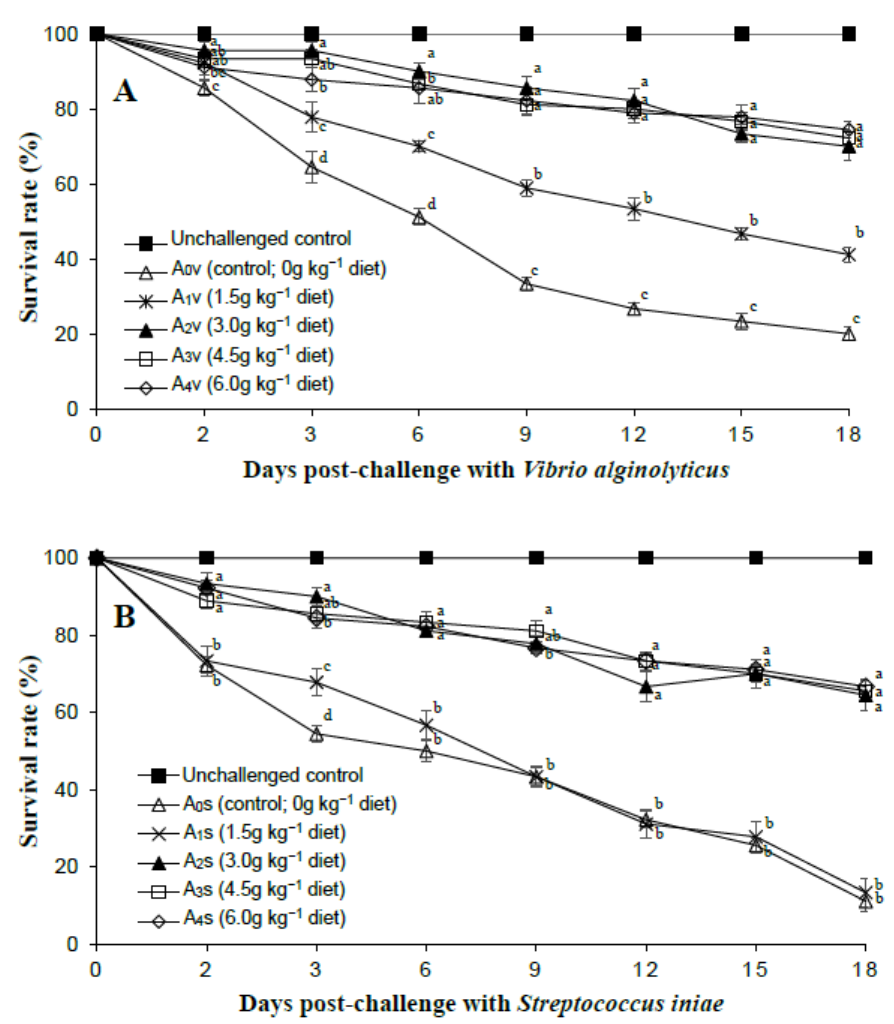
Figure 1. The curves of survival rate of Vibrio alginolyticus - ( A ) and Streptococcus iniae ( B )-challenged orange-spotted grouper fed with diets containing different levels of Antrodia camphorata (AC). Data represent the mean of 6 replicates (15 fish in each replicate) with the standard error. Data at the same time with different lowercase letters significantly differ ( p < 0.05) among treatments.